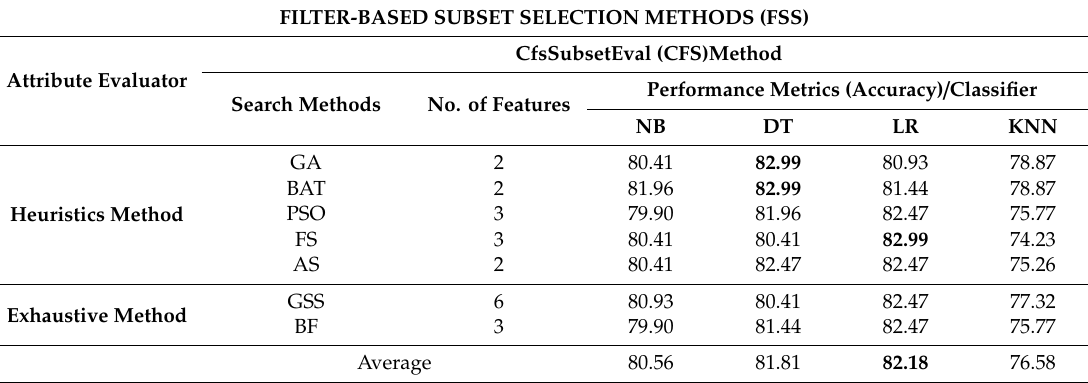
Table 12. Performance Accuracy Values of FS-based Prediction Models on KC3